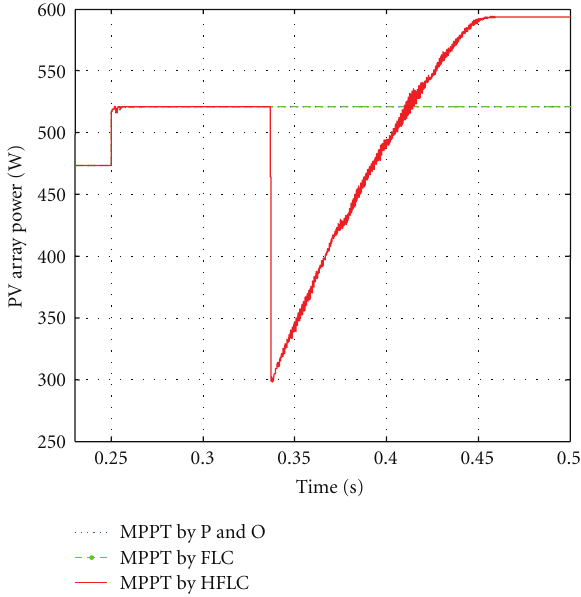
Figure 25: PV output power under partial change of irradiation 400 W/m 2 to 1000 W/m 2